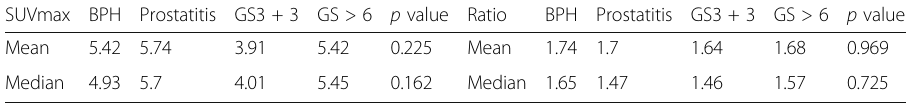
Table 2 Values of semi quantitative uptake according to biopsy